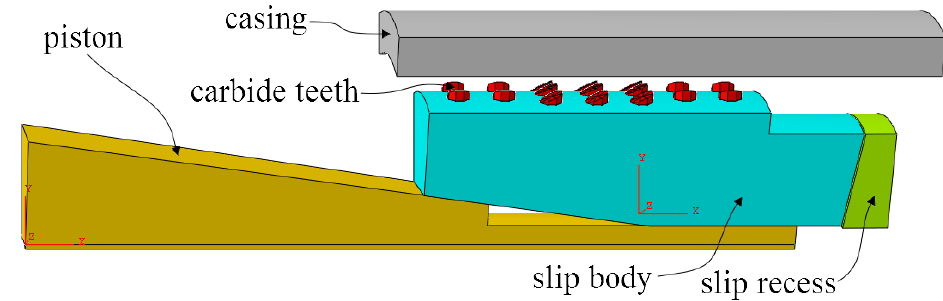
Figure 4. Assembly model of single slip.